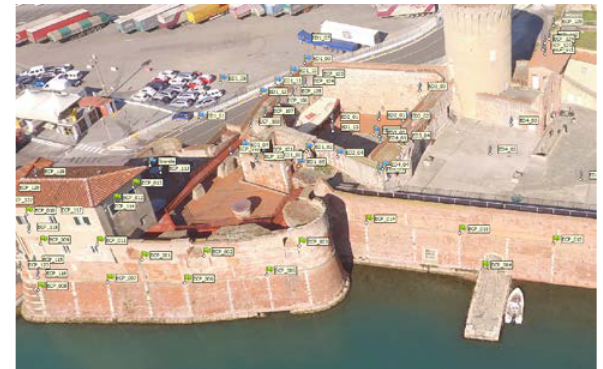
Figure 9: Collimated Existing Control Points